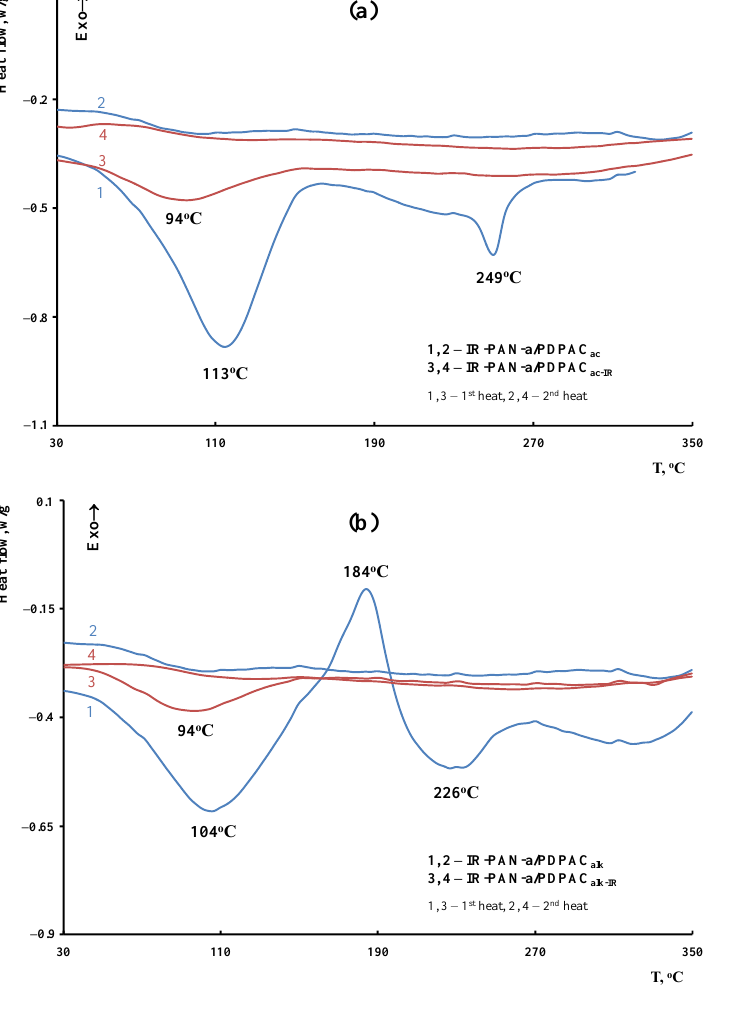
Figure 13. DSC thermograms of IR-PAN-a/PDPAC (1, 2) and IR-PAN-a/PDPAC IR (3, 4) prepared in an acidic ( a ) and an alkaline medium ( b ), upon heating in the nitrogen flow to 350 °С ( 1, 3 — first heating, 2, 4 — second heating).